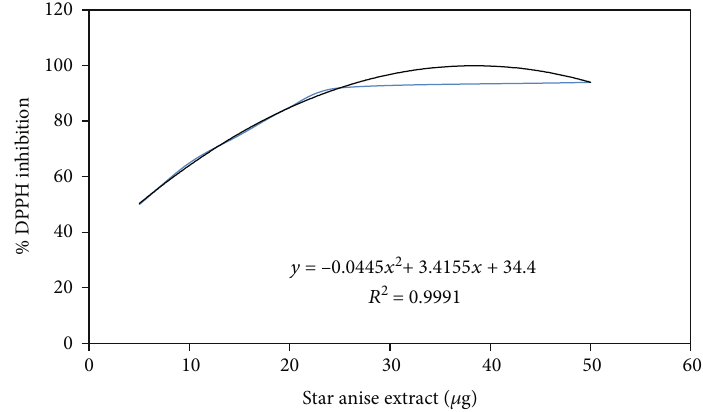
Figure 2: Inhibition of DPPH radical by star anise